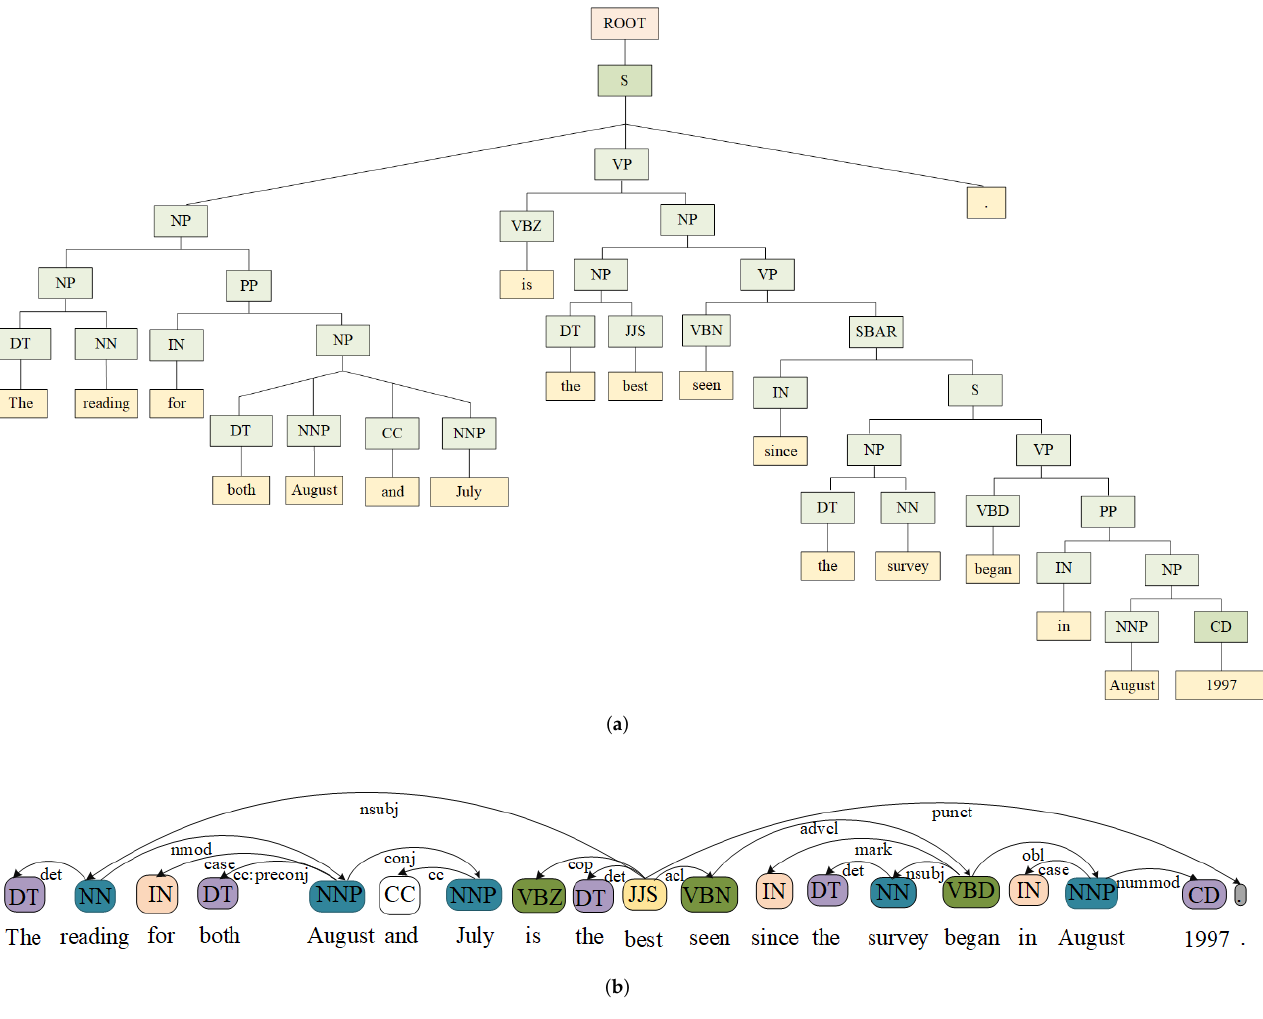
Figure 1. S 1 : ( a ) constituency parser; ( b ) dependency parser. S 1 : The reading for both August and July is the best seen since the survey began in August